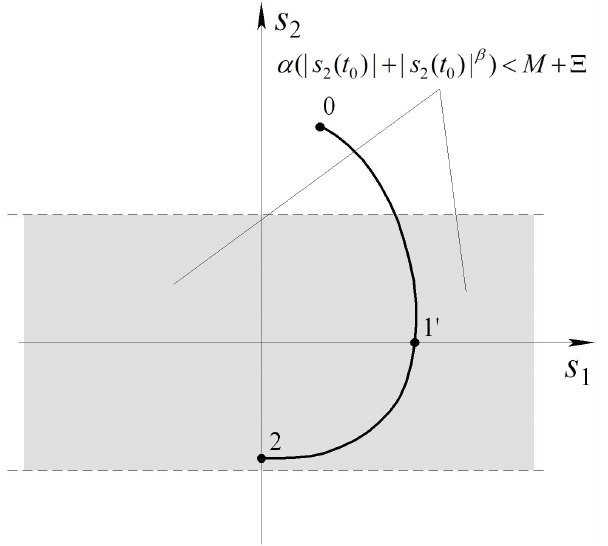
Figure 3. Phase portraits under initial conditions from the first and third quadrants (Situation 2).